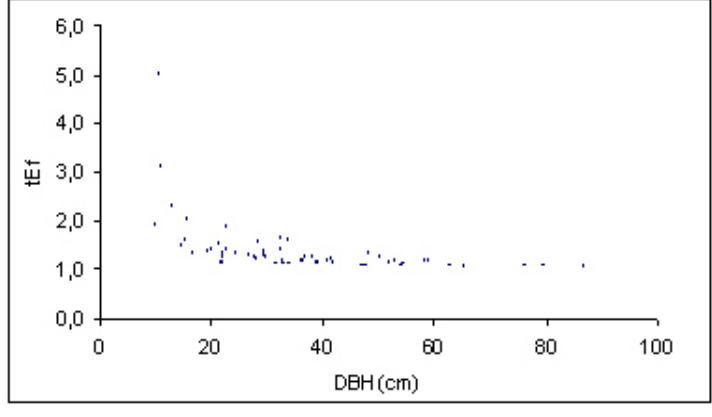
FIGURE 10 . Scattergram of expansion factors as a function of DBH.